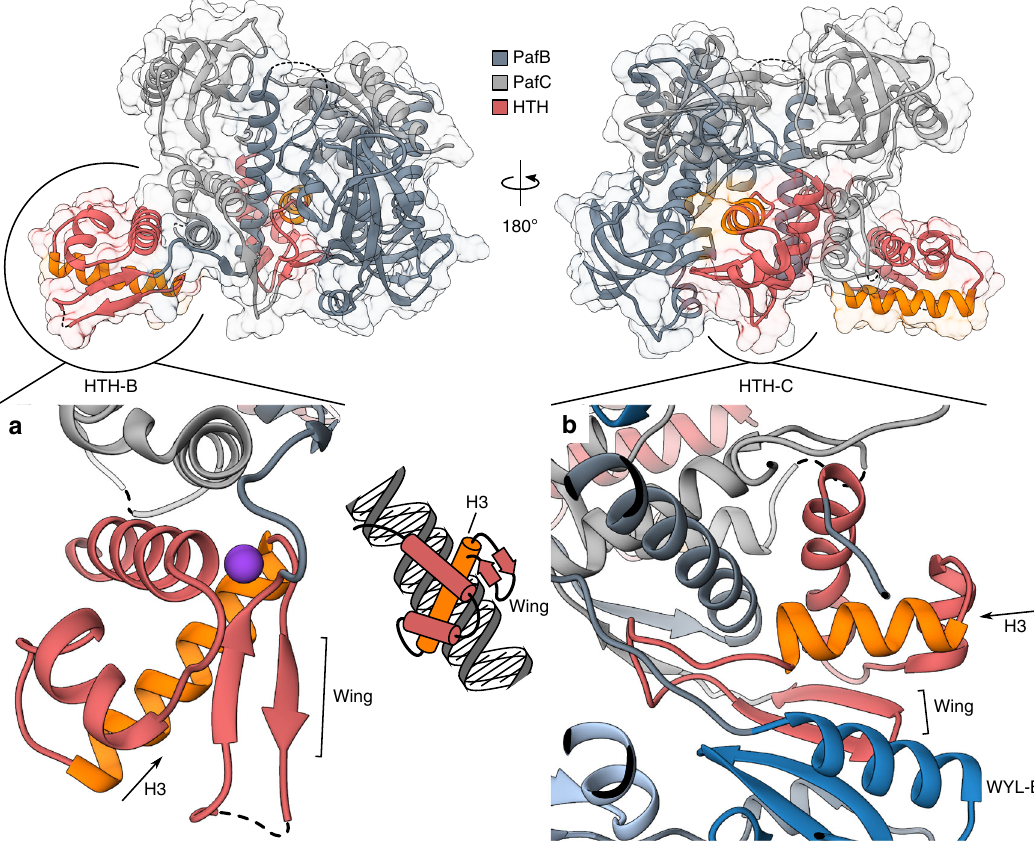
Fig. 2 The non-activated conformation of PafBC buries the HTH domain of PafC. a The HTH domain of PafB (HTH-B, red) adopts a typical winged helix- turn-helix fold (wHTH). The recognition helices (H3) of wHTH domains typically insert into the major groove of the DNA, while the wings establish contact to the minor groove (small inset, middle). The recognition helix of HTH-B (orange) is exposed and available to accept a DNA ligand. The main chain of H1 and the wing coordinate a potassium ion (lilac sphere). b The HTH domain of PafC (HTH-C, red) on the other hand forms part of the protein core. H3 of HTH-C (orange) is shorter by two helical turns compared to H3 of HTH-B, and an unstructured loop reaches into the protein core. In addition, the β -sheet of the wing extends the β -sheet of the WYL domain of PafB (WYL-B, blue). Dashed lines bridge gaps in the models. See also Supplementary Fig.